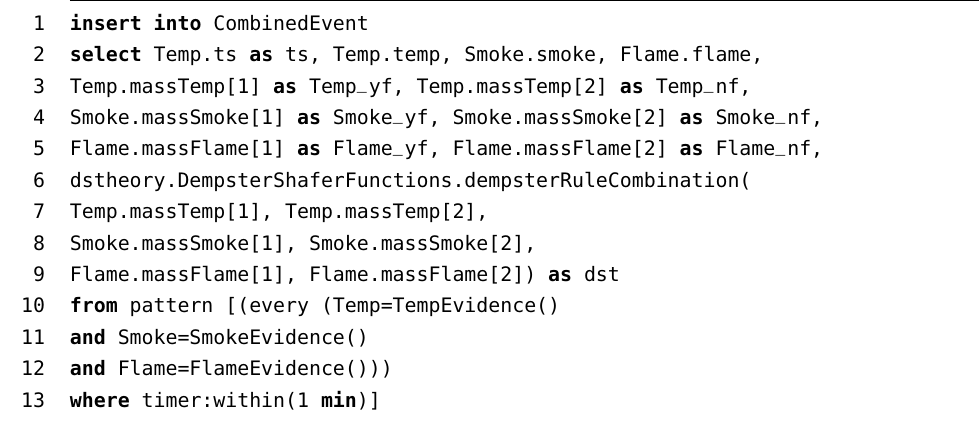
Code 5: CEP rule of Dempster combination